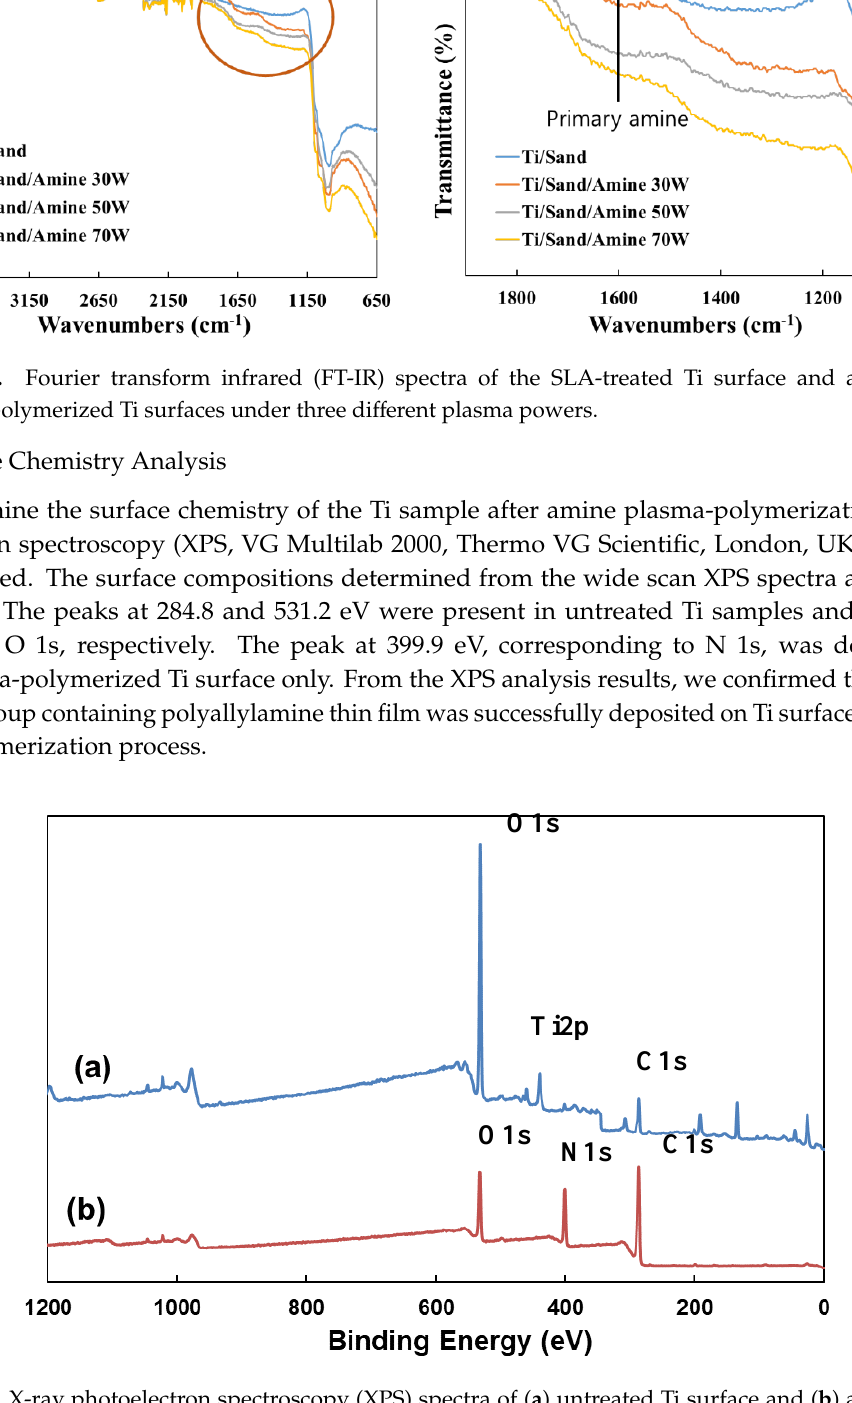
Figure 5. X-ray photoelectron spectroscopy (XPS) spectra of ( a ) untreated Ti surface and ( b ) amine plasma-polymerized Ti surface.